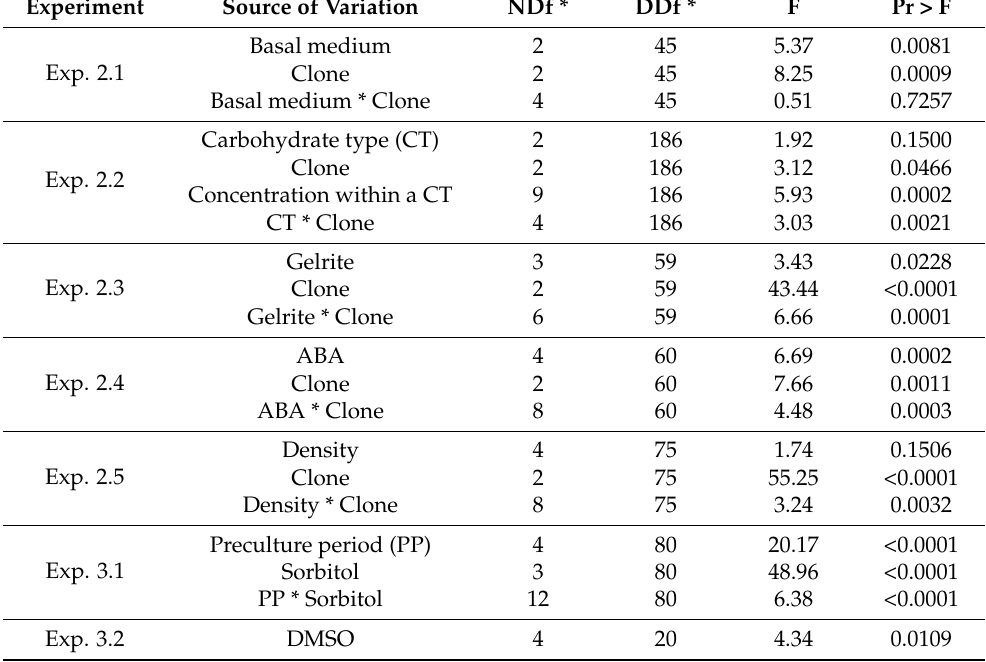
Table 4. Results of analysis of variance in Picea pungens somatic embryogenesis maturation experiments. Experiment